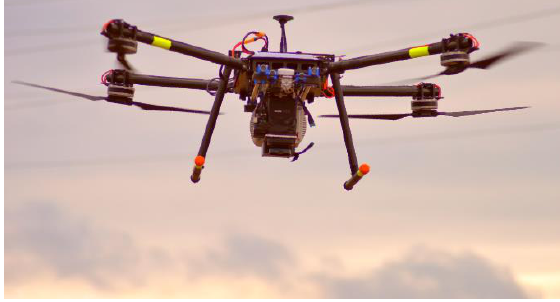
Figure 4: UAV Therefore, we use 28-inch rotors with motors of 120 KV. The rotors are positioned as a pusher, which means they look downward and are located under the arms of the quadrotor. There is a noticeable aerodynamic advantage which also re- sults in better efficiency and flight time.